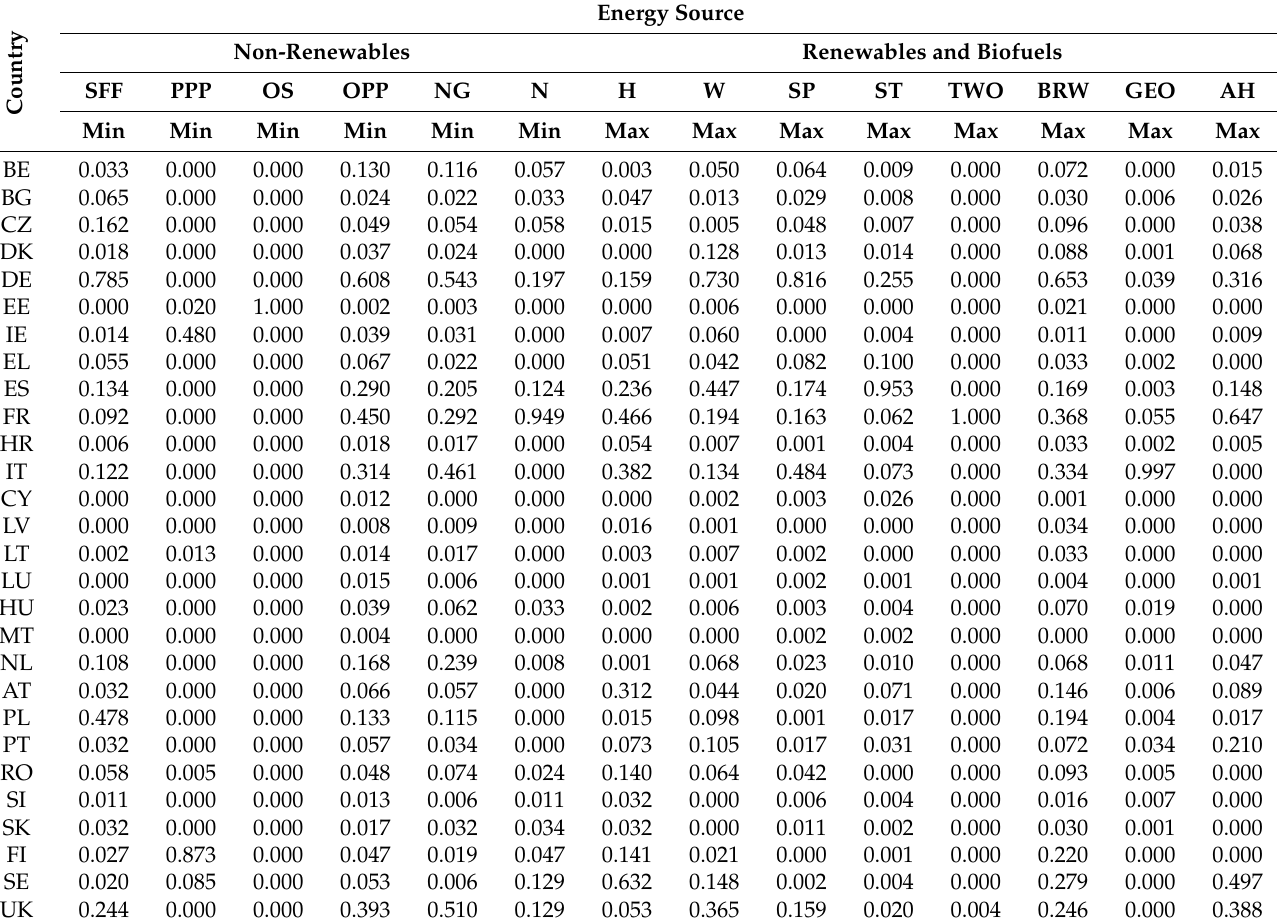
Table 2. Energy consumption in EU countries in 2015—normalization